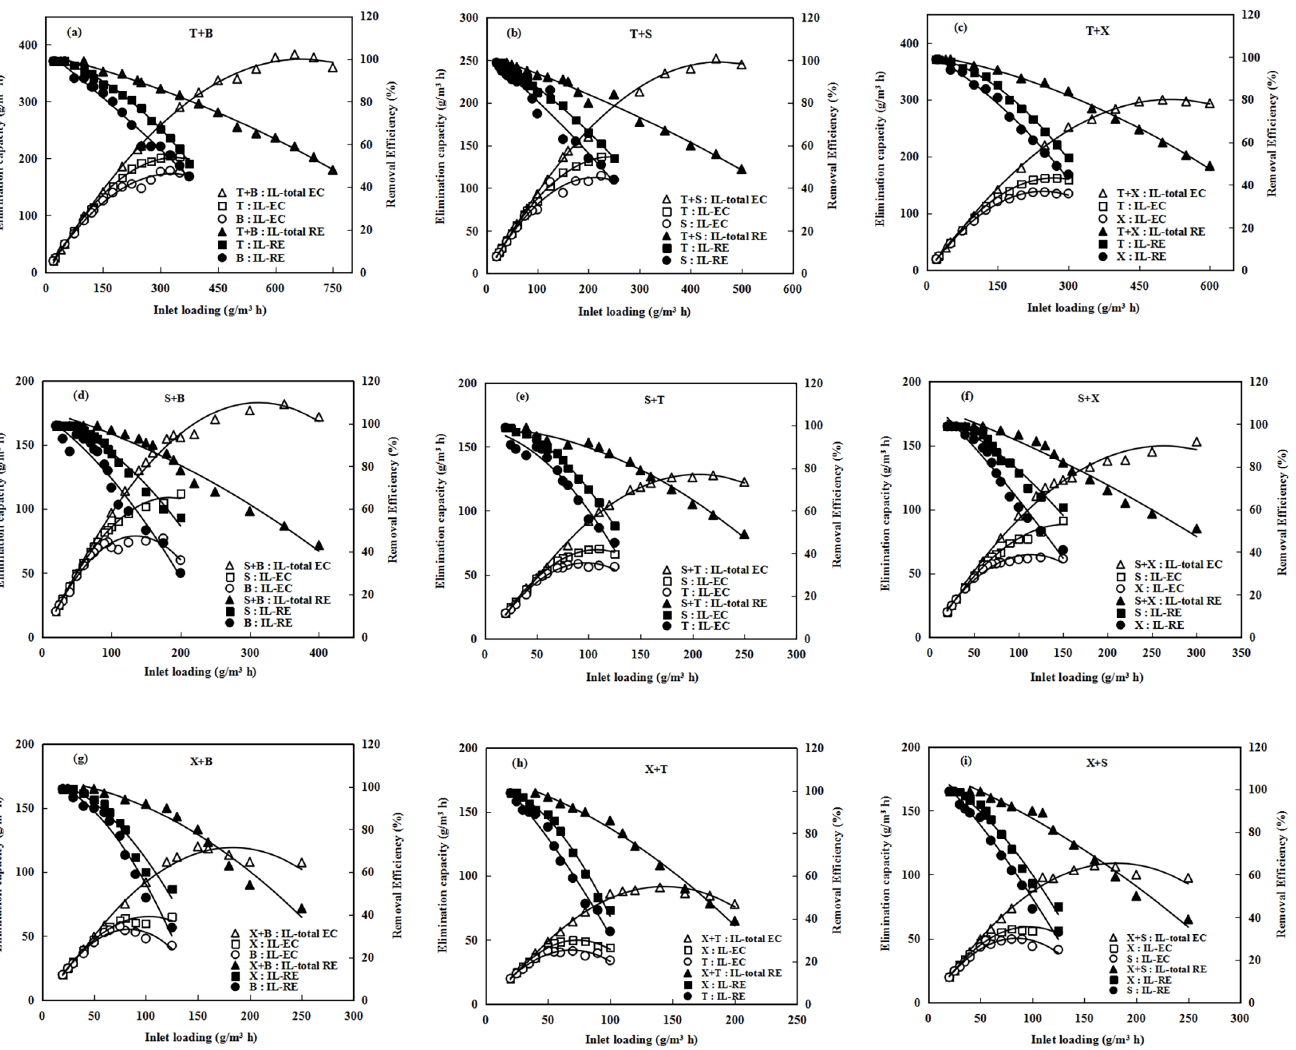
Fig 3. Comparison of elimination capacities and removal efficiencies of binary gases with inlet loadings. B: benzene; T: toluene; X: xylene; S: styrene.